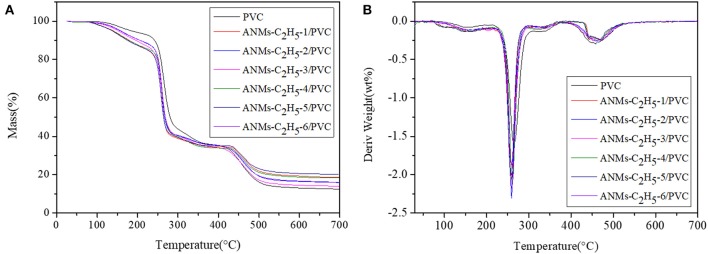
(A) TGA and (B) DTG curves of pure PVC and ANMs-C2H5-X/PVC films.